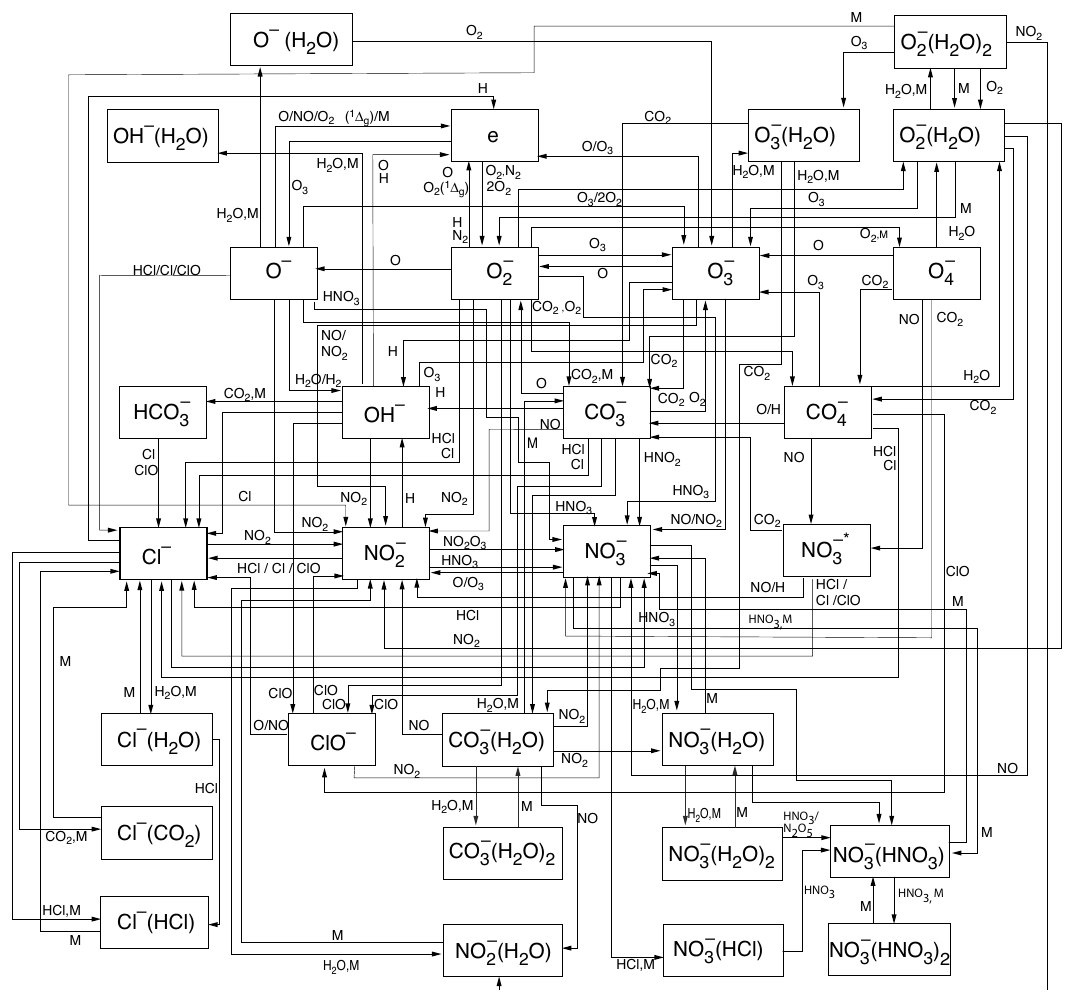
Fig. 1. Block diagram for the negative ion scheme of the SIC model. The various ions in the blocks are either the reactants or the final products of the reactions sketched by the connecting arrows. The arrows are labelled with the neutral constituents taking part in the reactions. Note that photodetachment and photodissociation reactions are not shown in the diagram.